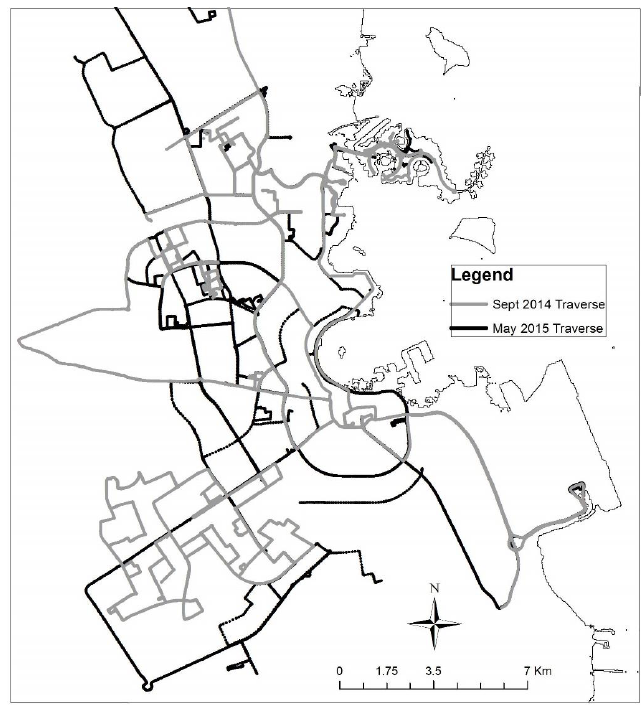
Figure 2. Vehicle temperature traverses across the study area, Doha. Coverage on 8 and 9 September 2014 and 12, 14, and 15 May 2015.